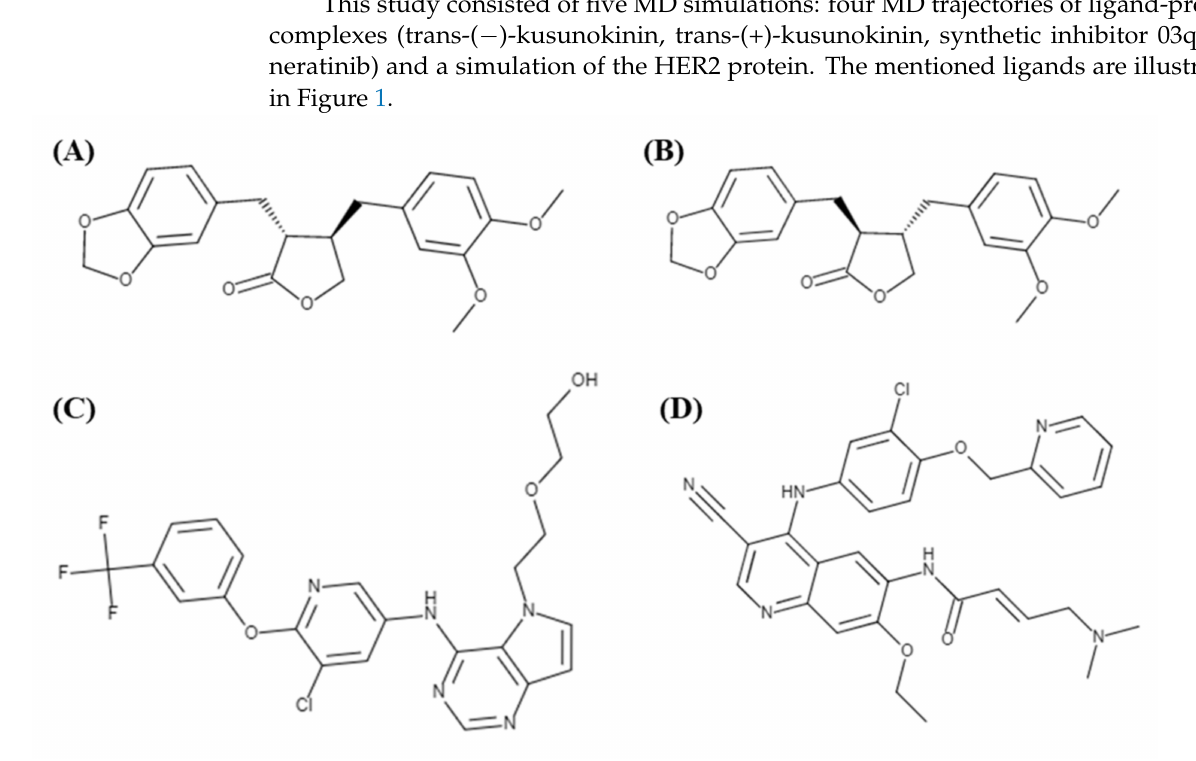
Figure 1. Ligands used in HER2 MD simulations: ( A ) trans-( − )-kusunokinin, ( B) trans-(+)-kusunokinin, ( C) synthetic inhibitor 03q, and ( D ) neratinib